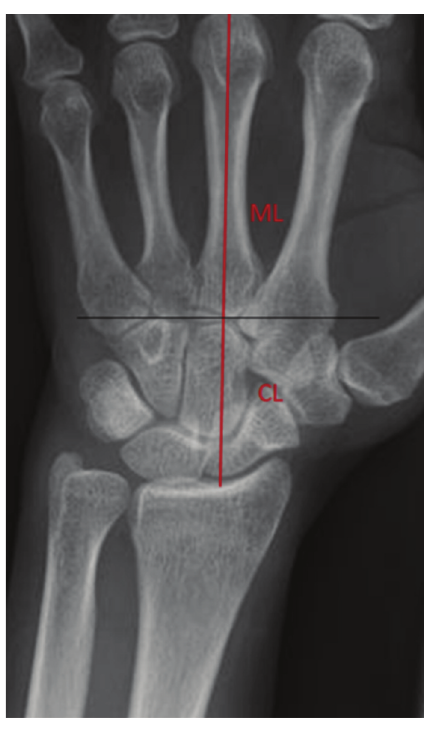
ML is the metacarpal length and CL is the carpal height. Fig. 1: Carpal Height Ratio (CHR) = CL/ML.